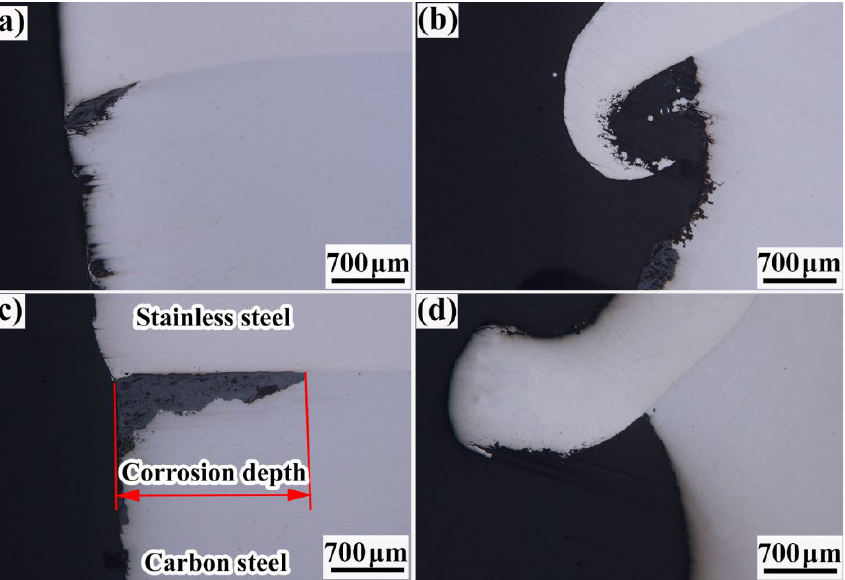
Figure 15. Illustration of corrosion depths in composite interfaces of various rebars: ( a ) 20MnSiV/316L rebar; ( b ) 35#/316L rebar; ( c ) 45#/316L rebar; ( d ) 55#/316L rebar.